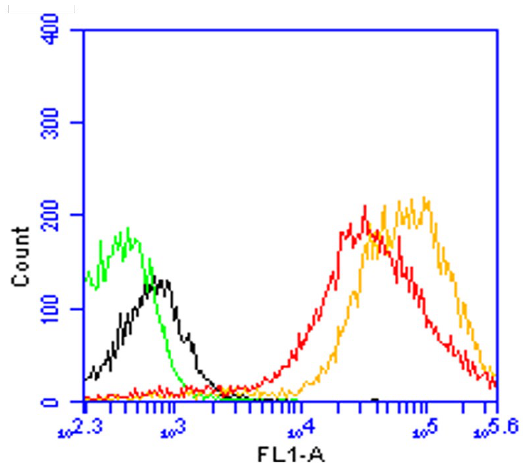
Figure 3. Flow cytometric analysis of the uptake of 100 µ g of FITC-BSA-loaded microparticles (yellow curve) and FITC-BSA solution (red curve) by DCs (DC 2.4) after 2 h of incubation at 37 ◦ C. The uptake of FITC-BSA loaded microparticles was significantly higher than that of the FITC-BSA solution ( p < 0.05). The green and the black curves represent cells that did not receive any fluorescent dye.